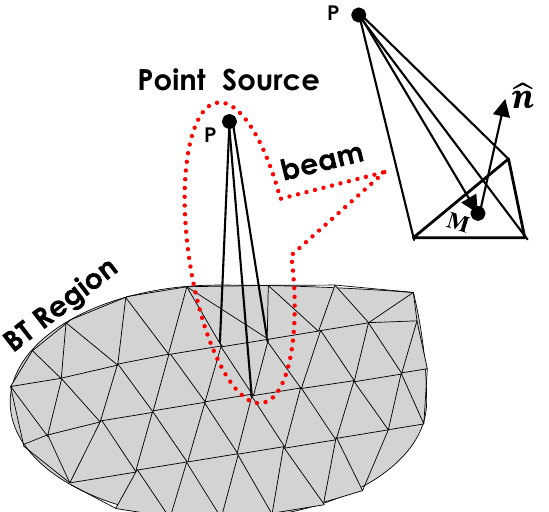
Figure 3. The generation of initial beams. P is the point source, M and ˆ n are the center and normal of the